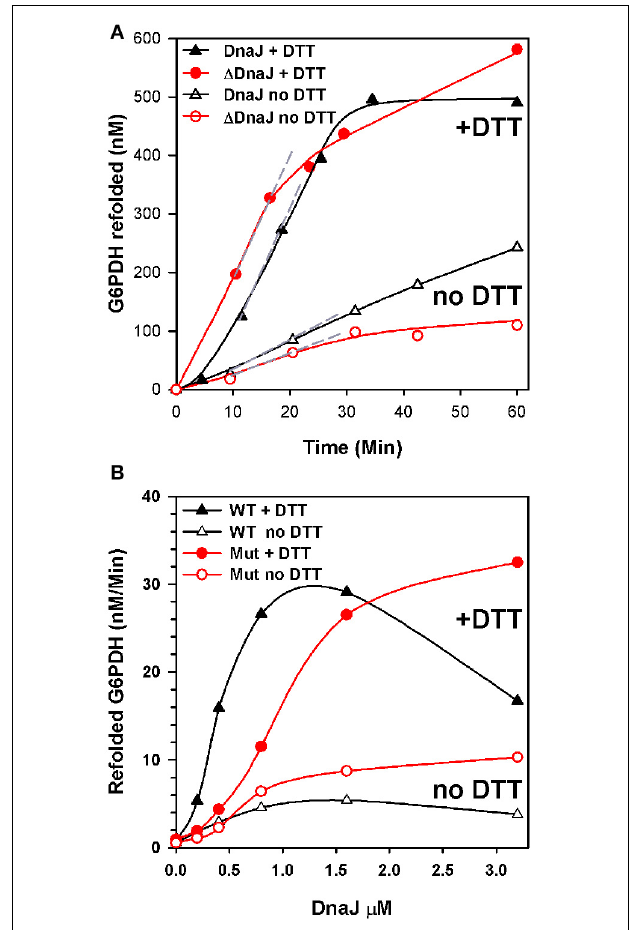
FIGURE 3 | (cid:2) DnaJ is as effective a co-chaperone as DnaJ. (A) Time-dependent refolding of heat denatured G6PDH. 0.65 μ M G6PDH was first heat-denatured and then supplemented at 30 ◦ C with 5 μ M DnaK, 2 μ M GrpE and 1.6 μ M DnaJ or 1.6 μ M (cid:2) DnaJ in absence (empty symbols) or presence (filled symbols) of 5mM DTT. ( B ) Rates of G6PDH refolding obtained from the maximal slopes (shown as dotted gray lines in A ) at different concentrations of DnaJ or (cid:2) DnaJ, as